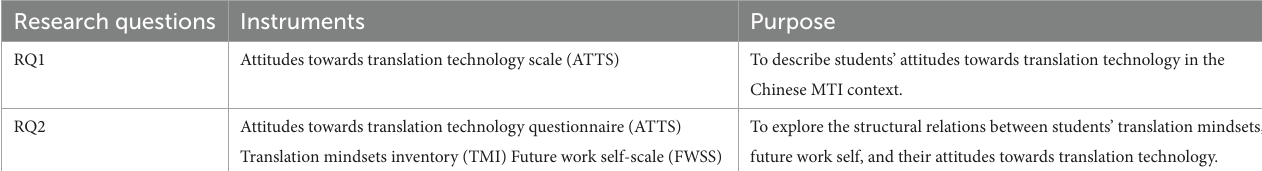
TABLE 3 Measure